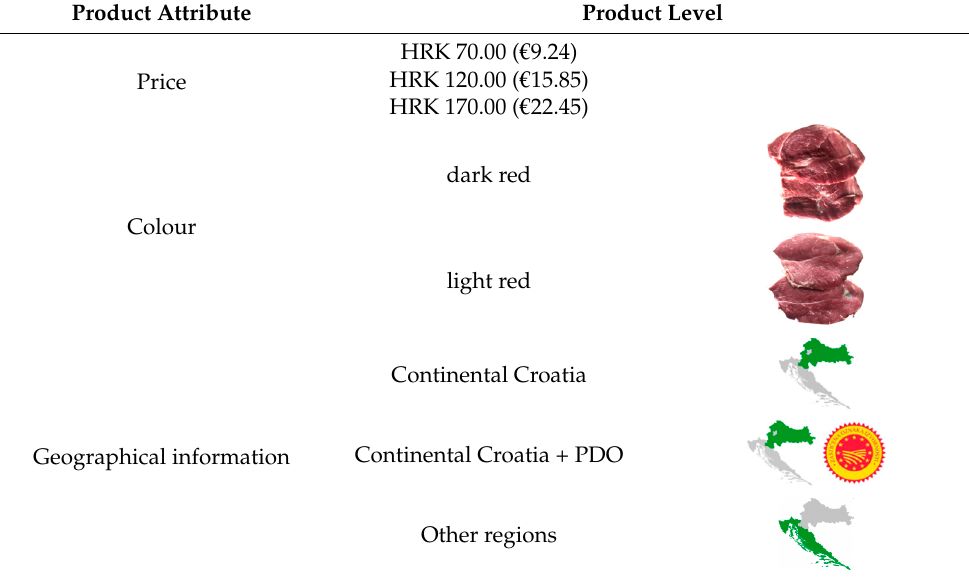
Table 1. Attributes and levels used in the choice experiment on fresh pork ham without bones.